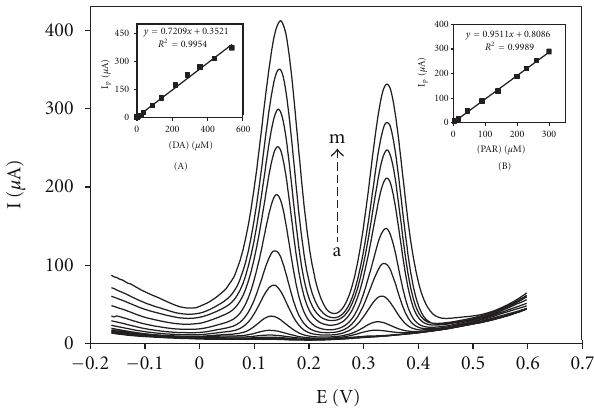
Figure 5: Di ff erential pulse voltammograms for di ff erent concen- trations of DA and PAR mixtures as (a) 1 + 0.5, (b) 3 + 1, (c) 5 + 1.5, (d) 10 + 2, (e) 25 + 3, (f) 40 + 15, (g) 90 + 45, (h) 140 + 90, (i) 220 + 140, (j) 290 + 200, (k) 360 + 230, (l) 440 + 260, and (m) 540 + 300, respectively, in which the first value is the concentration of DA in μ M and the second value is the concentration of PAR in μ M. Insets: (A) plot of peak currents as a function of DA concentration. (B) Plot of the peak currents as a function of PAR concentration.